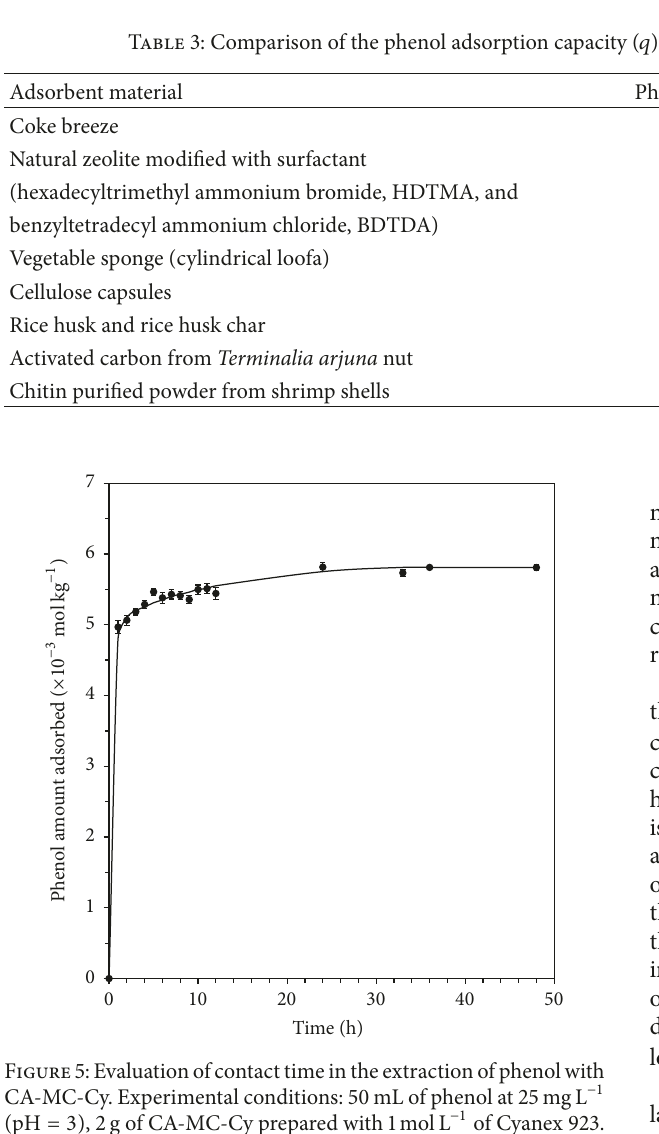
(pH = 3 ), 2 g of CA-MC-Cy prepared with 1mol L −1 of Cyanex